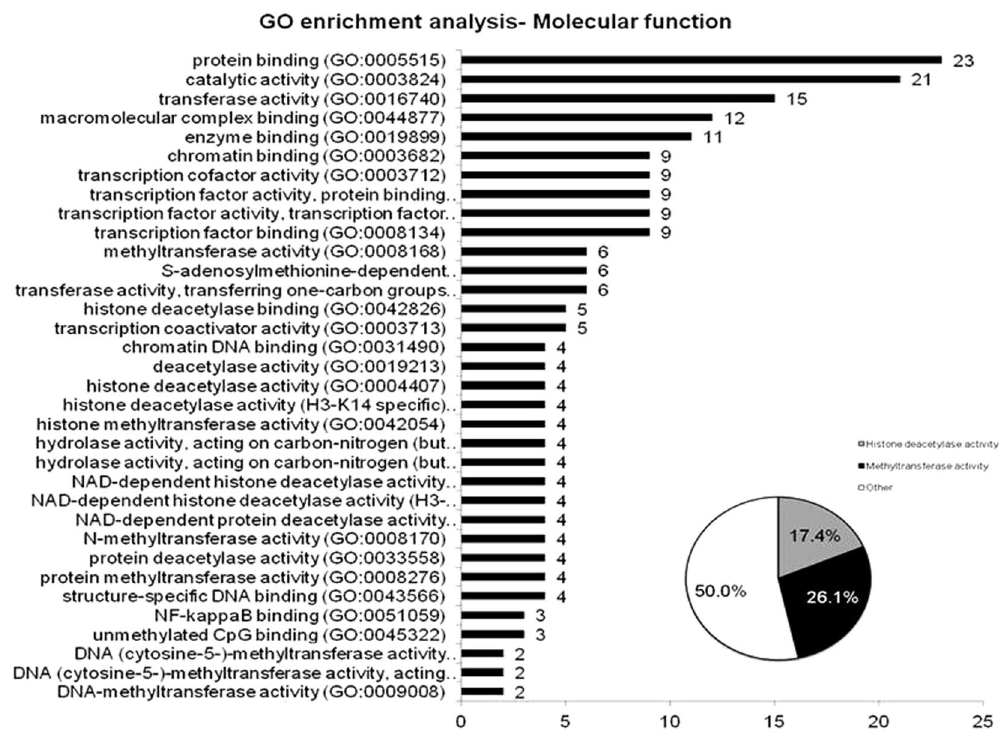
Figure 2. MSC from BALf of BOS patients present a deregulated expression of histone deacetylases and methyltransferases, and a pro-fibrotic phenotype. Functional categorization of upregulated genes in MSC of BOS samples based on gene ontology (GO)